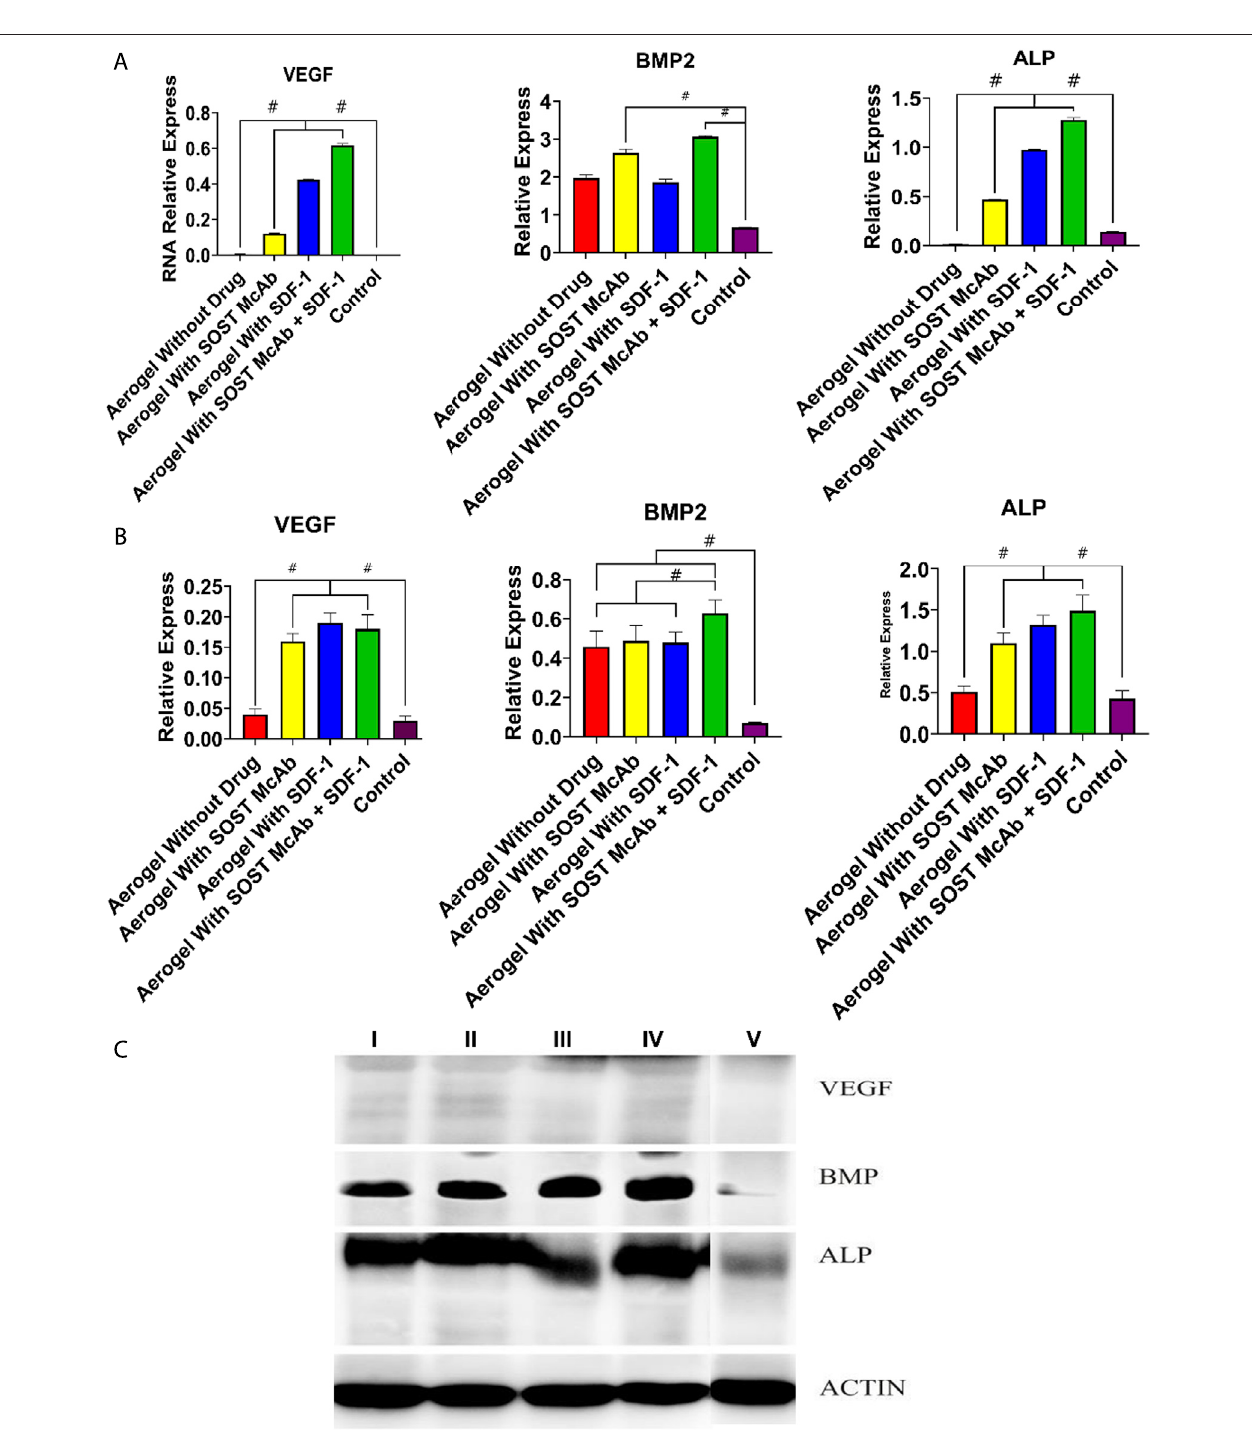
FIGURE10 | ResultsofPCR and Westernblot detection. (A) The results ofPCR ofVEGF,BMP2, and ALP (B,C) . The results of Western blot of VEGF, BMP2, and ALP. The bar graph showed that the aerogel loaded with SOST McAb and SDF-1 had the best effect on promoting new bone and neovascularization. Group I aerogel scaffold without loading drugs, Group II aerogel scaffold loaded with SOST McAb, Group III aerogel scaffold loaded with SDF-1, Group IV aerogel scaffold loaded with SOST McAb + SDF-1, Group V the control group without scaffold implant. VEGF, vascular endothelial growth factor; BMP2, Bone Morphogenetic Protein 2; ALP, alkaline phosphatase. #, p ＜